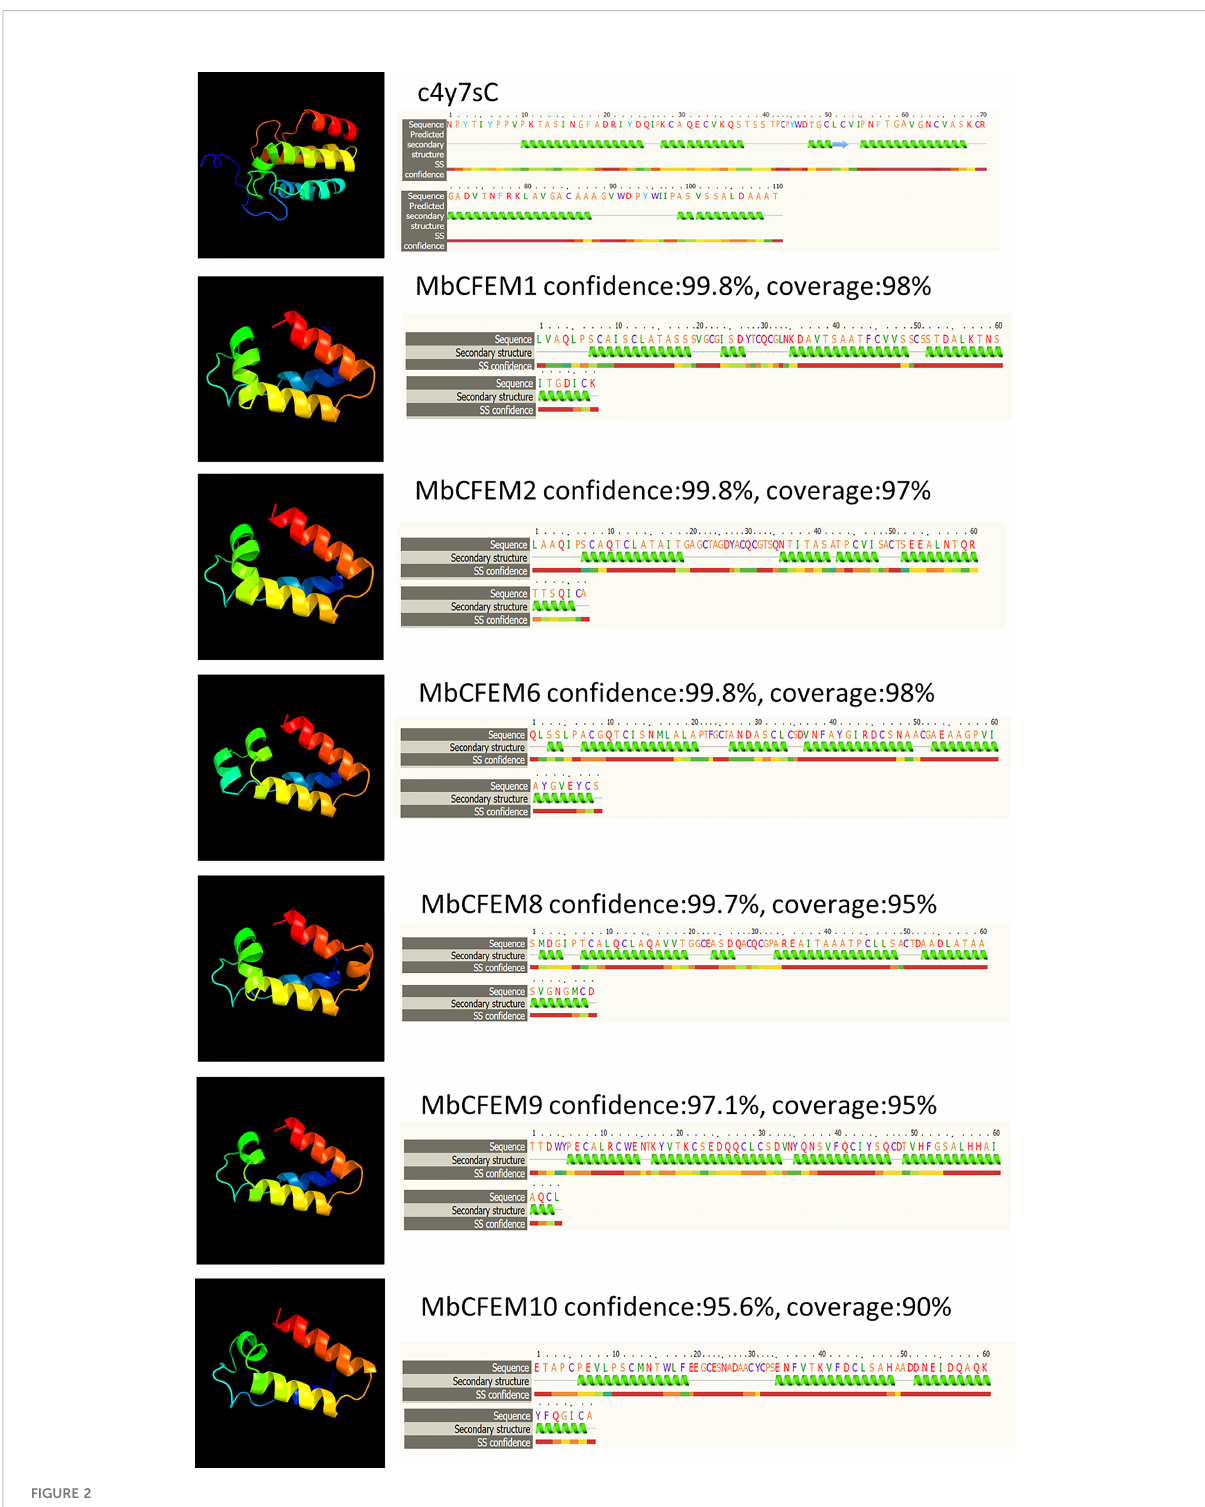
FIGURE 2 Analysis of structural models of candidate MbCFEM effectors by the Phyre2 Server. The amino acid residues of these effectors were modeled on the crystal structure of the Common in Fungal Extracellular Membrane (CFEM) domain c4y7sC from C. albicans Csa2 with more than 95% con fi dence. The amino acid sequences of candidate MbCFEM effectors are shown in the top line. The sequences on the next line show residues, which were colored according to a property-based scheme: yellow (A, S, T, G, P: small/polar), green (M, I, L, V: hydrophobic), red (K, R, E, N, D, H, Q: charged) and purple (W, Y, F, C: aromatic+cysteine). Green helices represent a -helixes, blue arrows represent b -strands and faint lines represent